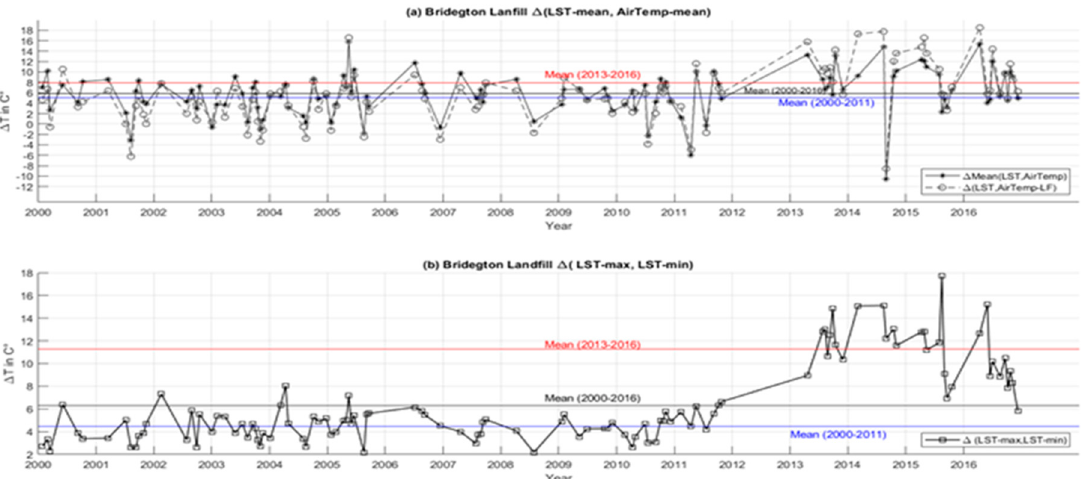
Figure 3. ( a ) Comparison of mean LSTs and mean air temperatures and ( b ) a comparison of the maximum and minimum LSTs for given image dates for Bridgeton landfill.